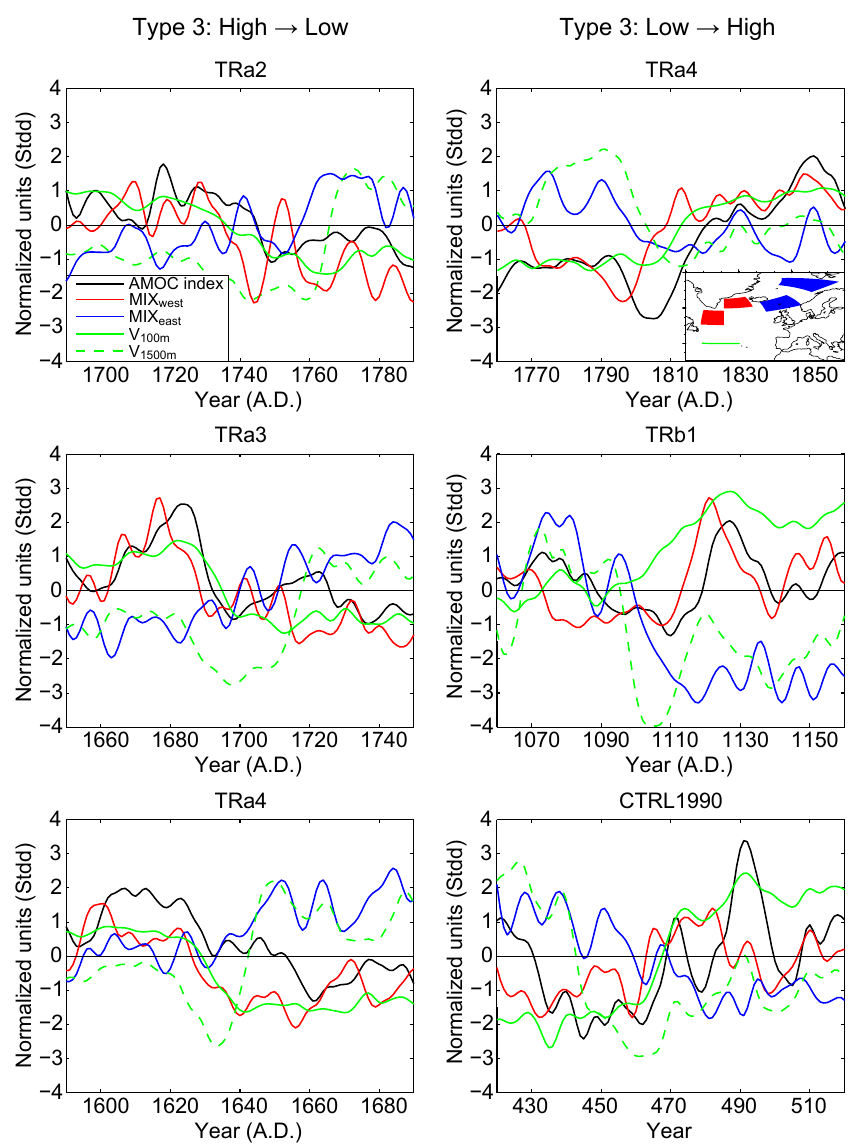
Fig. 8. Low-pass filtered and normalized time series of the AMOC index, the mixed layer depth averaged over the westerly (MIX west ) and easterly (MIX east ) DWF regions and the mean velocity across the boundary between the two gyres for the top 100m (V 100m ) and for a mean depth of 1500m (V 1500m ). The areas that are used for the calculation are indicated in the figure (the color of the time series corresponds to the color of the areas). Note that the applied low-pass filter is different to Fig. 2 and removes variations on time scales less than 10 years. The left column shows the Type 3 transitions from a high to a low AMOC index and the right column the transitions from low to